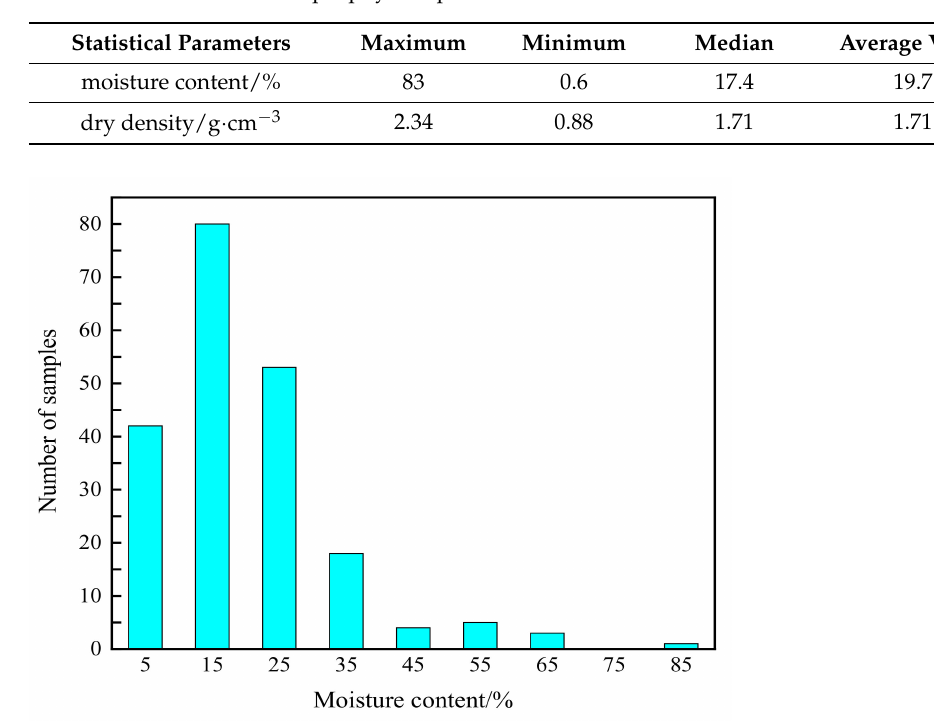
Table 1. Statistics of soil sample physical parameters.